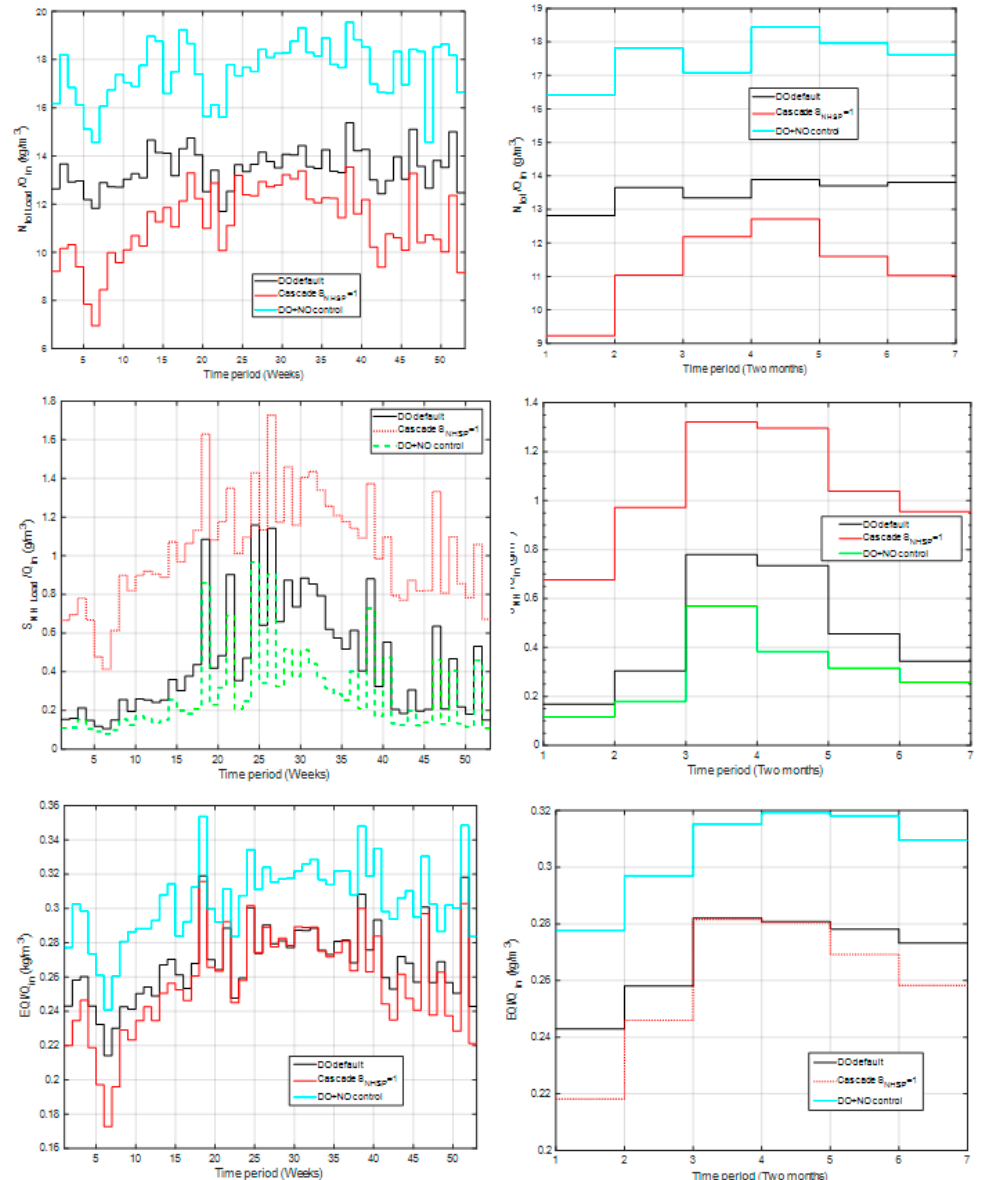
Figure 6. Weekly and bimonthly profiles of environmental indicators associated with emissions to water: N tot Load / Q in (g / m 3 ), S NH Load / Q in (g / m 3 ), and EQI / Q in (kg / m 3 ).